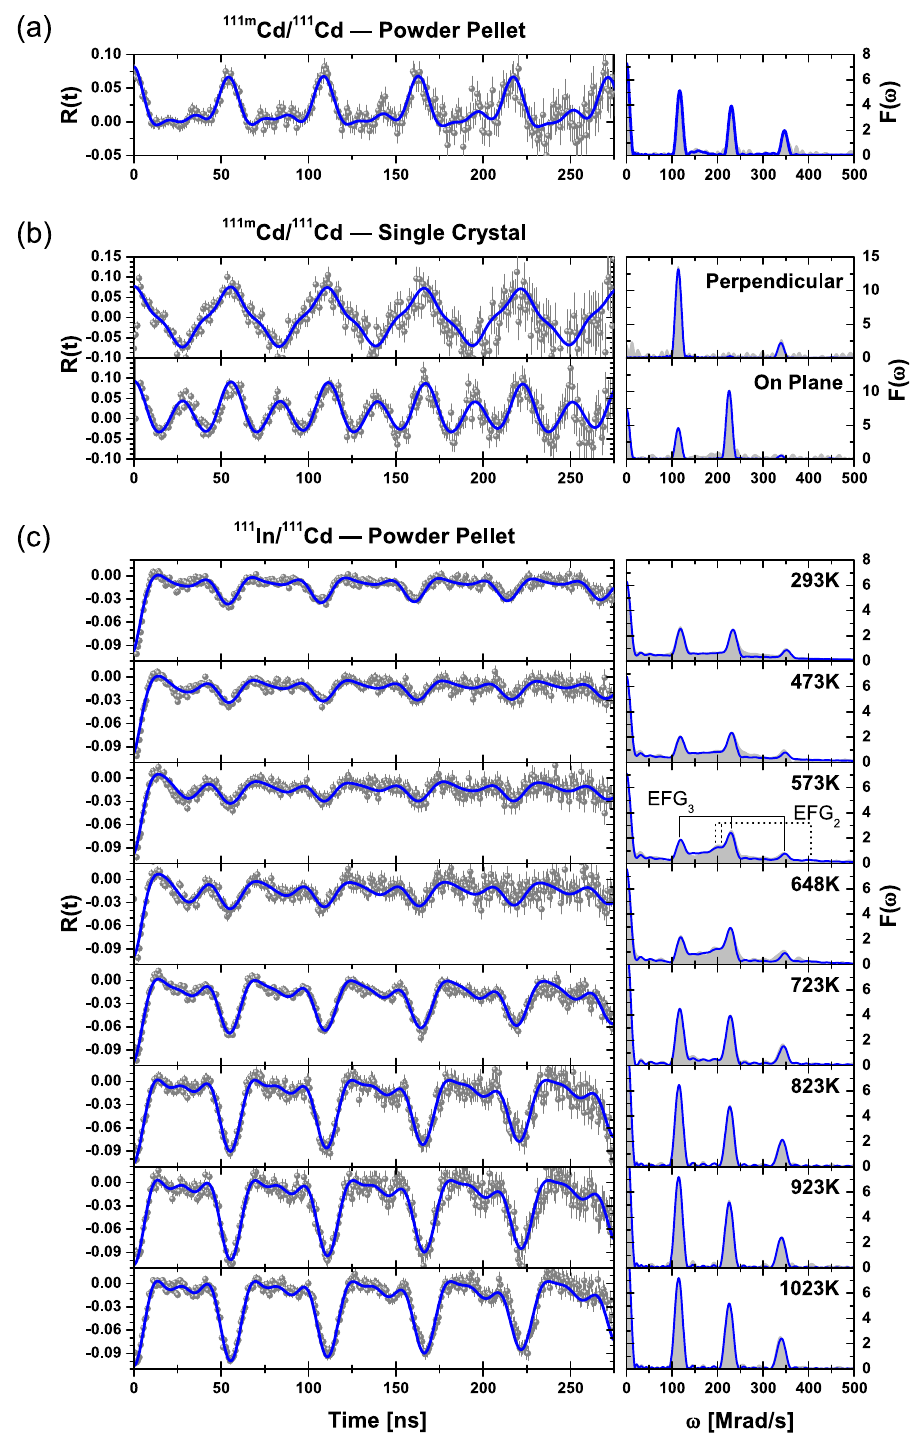
Figure 1. PAC spectra (symbols) and their fits (lines) (as well as their Fourier transforms) after implantation of 111 m Cd ( a ) in the powder pellet and ( b ) in the single crystal, and ( c ) as a function of temperature after diffusion 111 of In in the powder pellet. The triplet of frequencies associated with the EFGs of the intermediate (2) and final (3) states are shown in the Fourier transform at 573 K